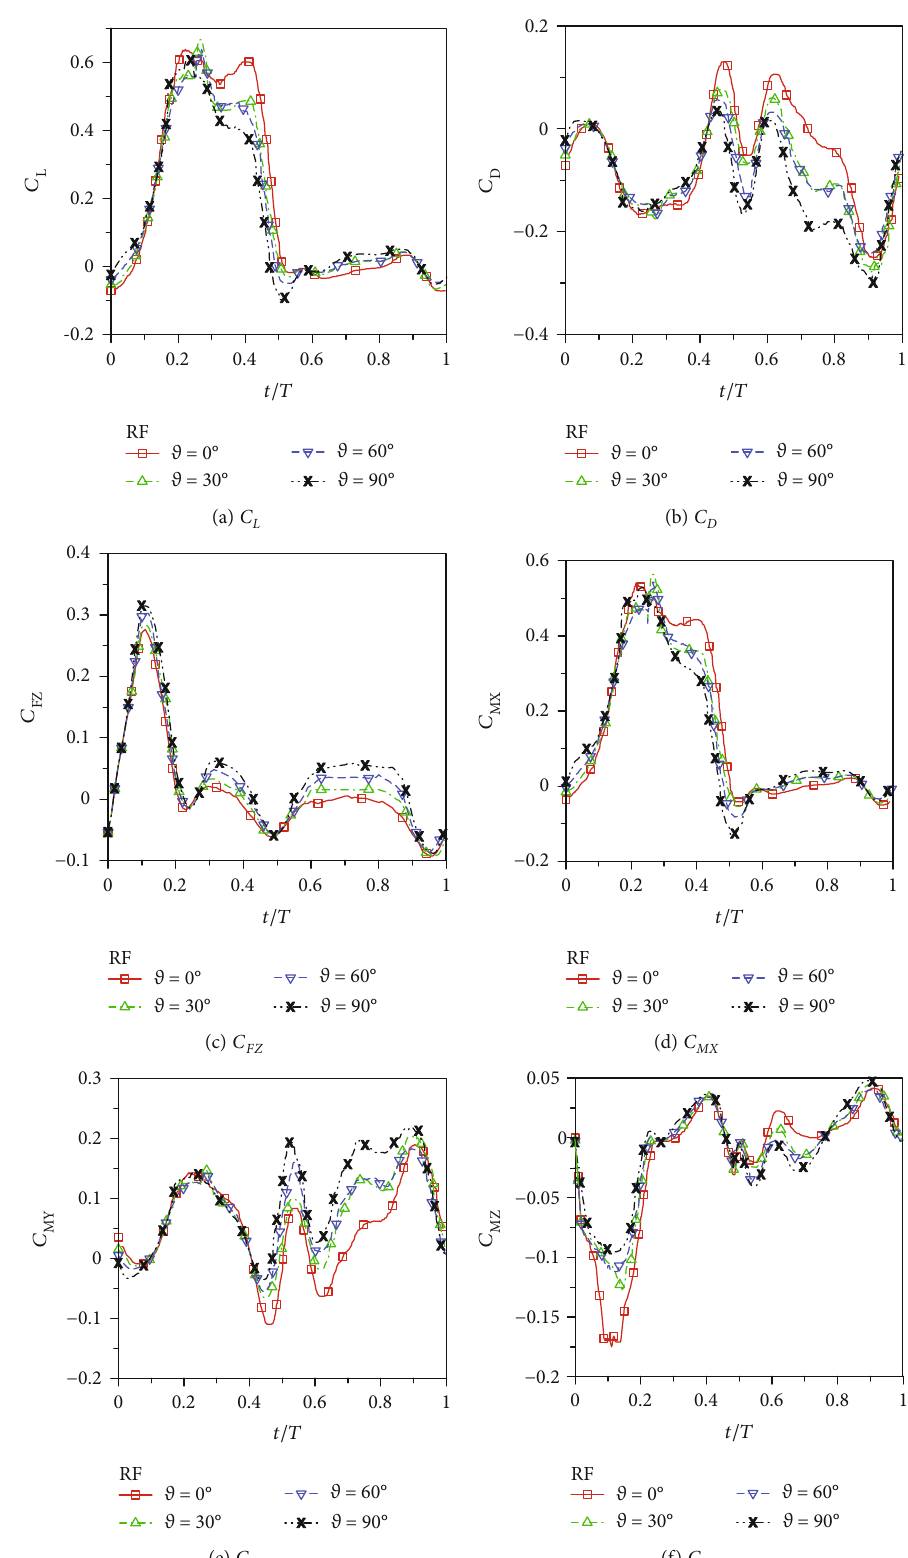
Figure 8: Coe ffi cients of instantaneous aerodynamic force and moment vs ϑ